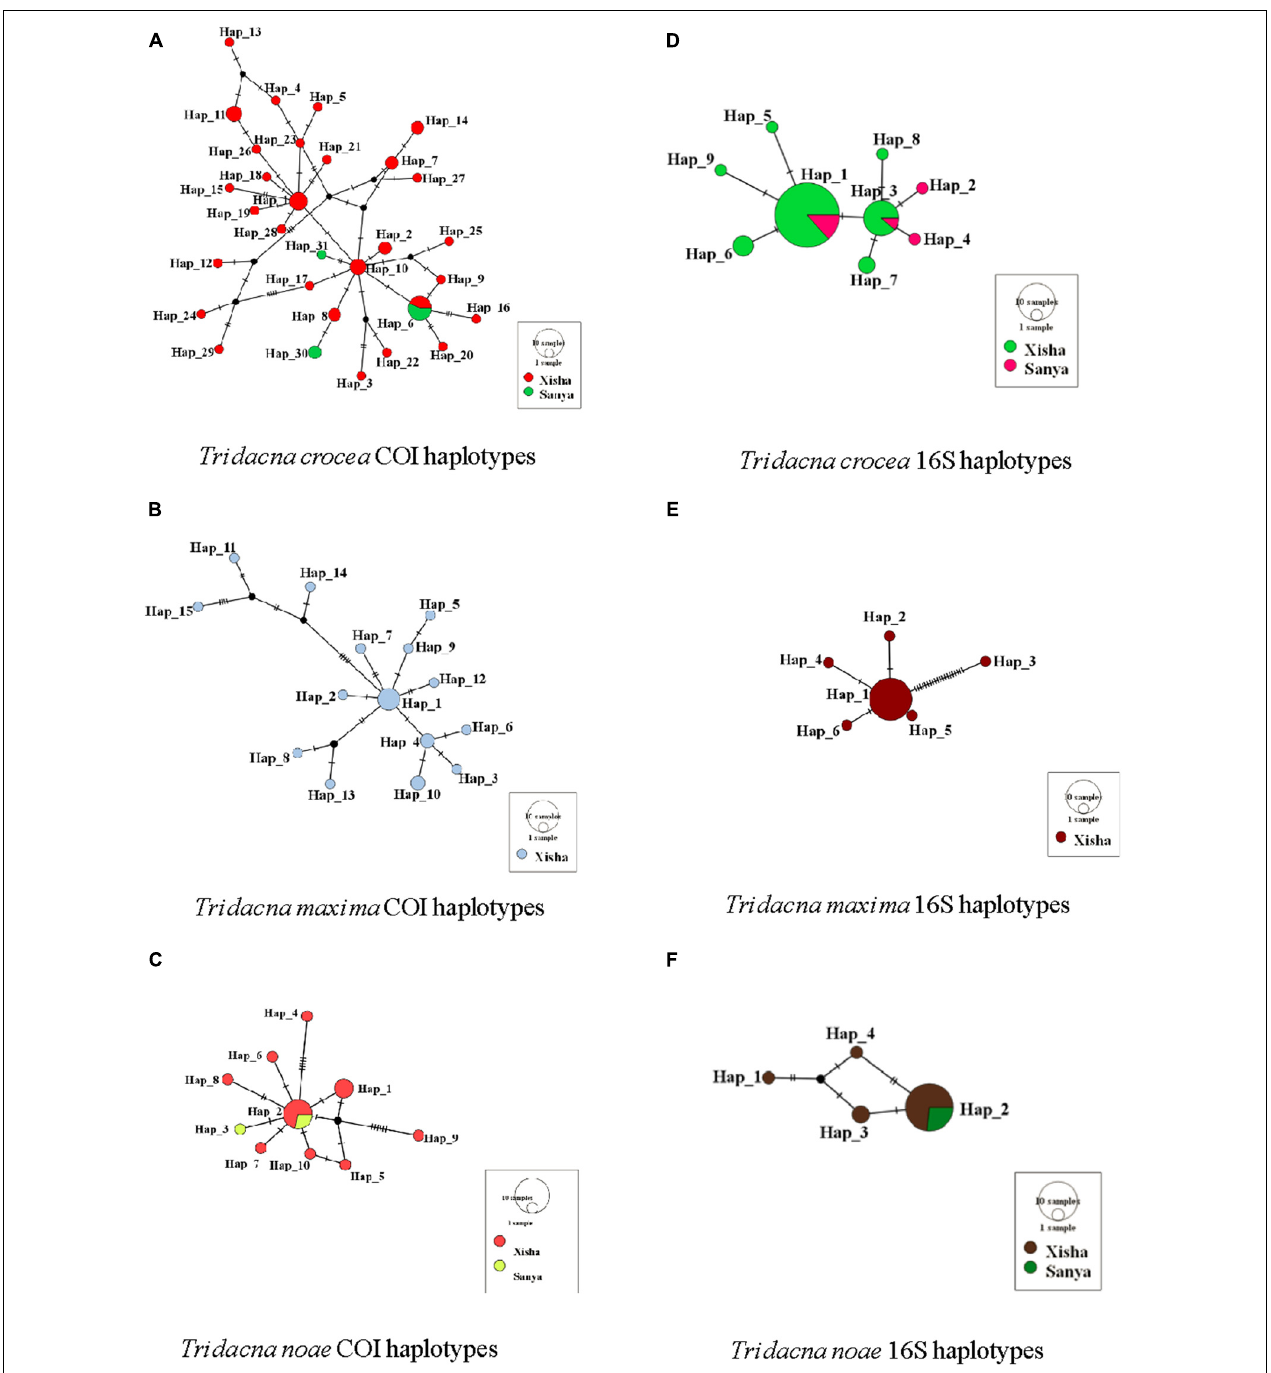
FIGURE 3 | Network of three giant clams for COI and 16S data. (A) Tridacna crocea COI haplotypes; (B) Tridacna maxima COI haplotypes; (C) Tridacna noae COI haplotypes; (D) Tridacna crocea 16S haplotypes; (E) Tridacna maxima 16S haplotypes; (F) Tridacna noae 16S haplotypes. The color of the circle indicates the geographic region, and the size of the circle indicates the haplotype